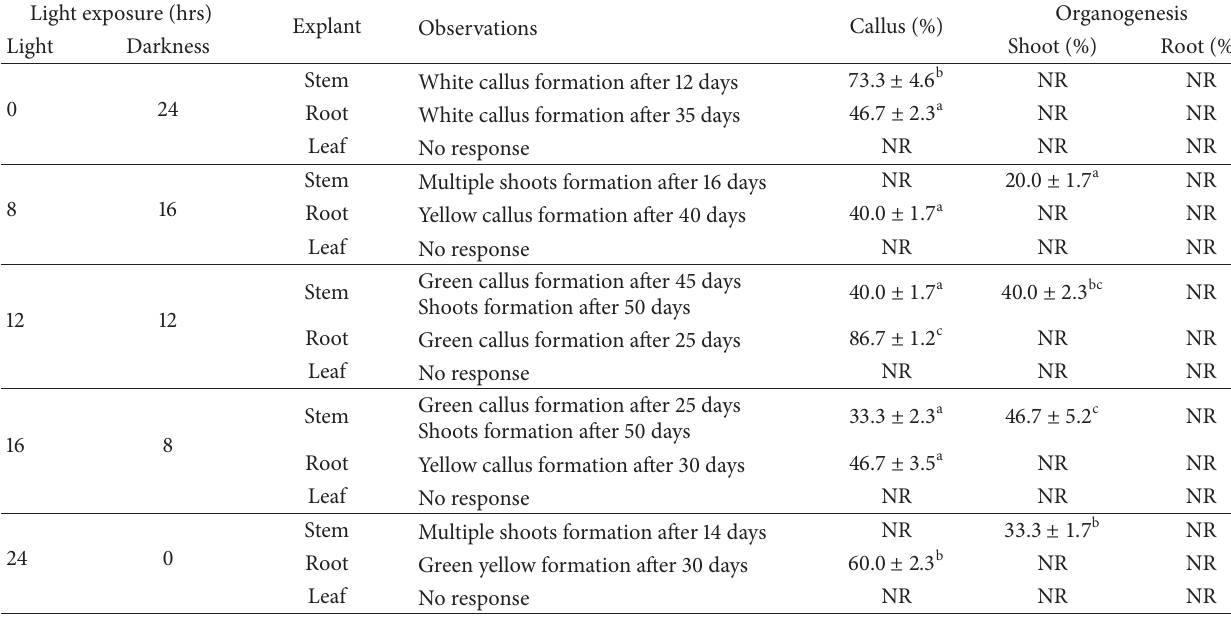
Mean ± SE, 𝑛 = 30 . Mean values with different letters (subject to different explant type) in the same column are significantly different at 𝑃 < 0.05 (NR: no response).